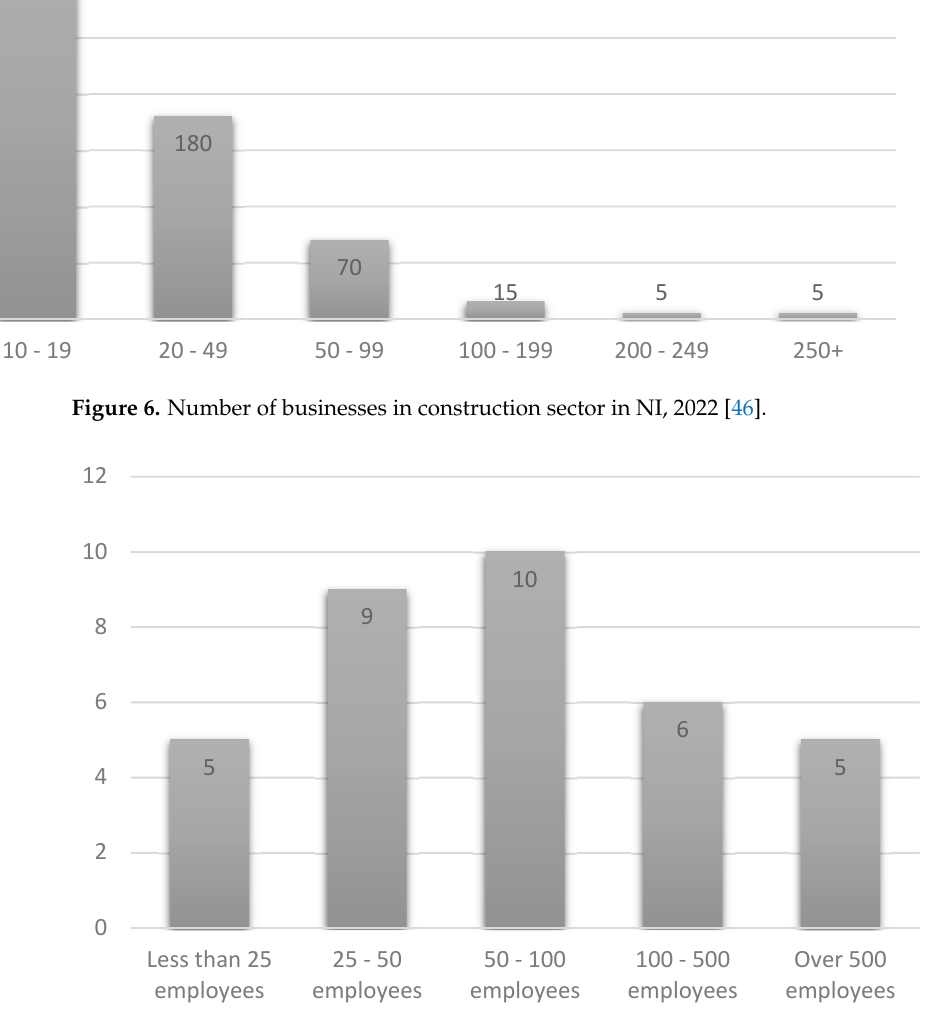
Figure 7. Respondents by size of organisation they represent.